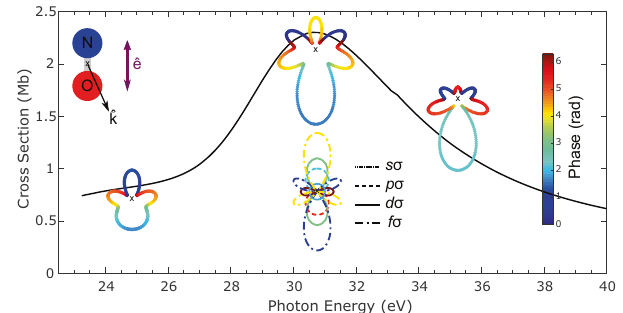
Fig. 1 Resolving the complex-valued photoionization amplitudes in the molecular frame across a shape resonance. Energy dependence of the complex-valued photoionization dipole amplitudes for the ionization of NO leading to the (4 σ ) − 1 c 3 Π state of NO + plotted as a function of the emission direction ^ k in the molecular frame for molecules oriented parallel to linearly polarized light in the region of the NO 4 σ ! k σ (cid:4) shape resonance. The computed magnitudes and phases are represented by the radius vector and the color of the line plots, respectively. The energy derivative of the PDA phases gives access to photoionization time delays. For photon energy of 31 eV at the peak of the resonance, the PDAs are dominated by the coherent superposition of partial waves up to l = 3 as shown.